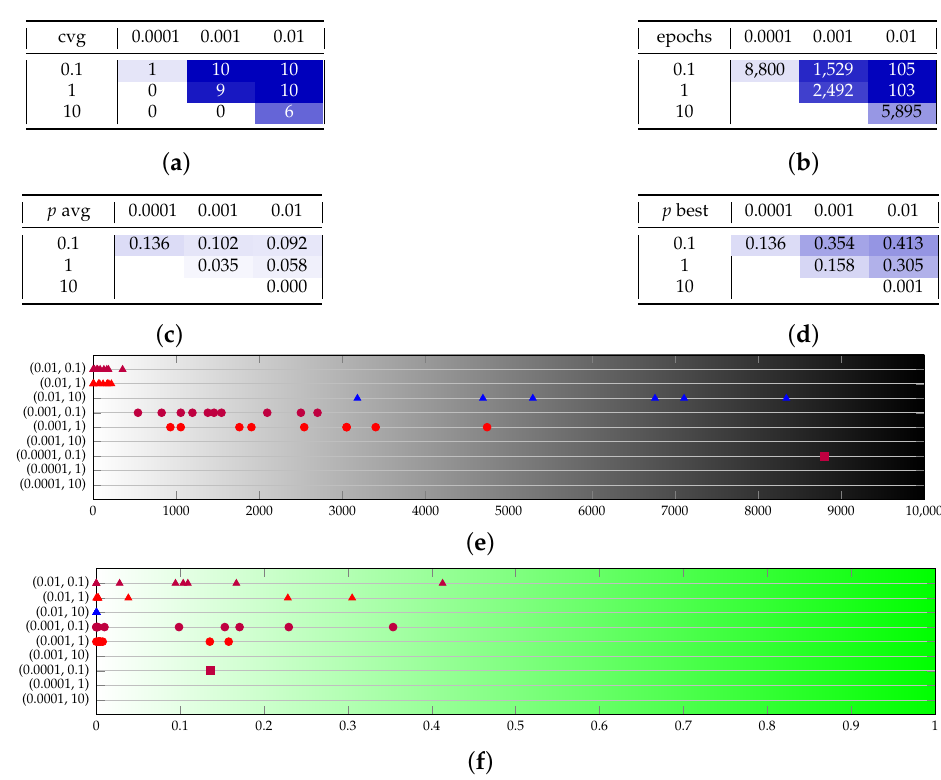
( e ) (e) Visual representation of the epochs before convergence. 1(0.0001,10)(0.0001,1)(0.0001,0.1)(0.001,10)(0.001,1)(0.001,0.1)(0.01,10)(0.01,1)(0.01,0.1) ( f ) (f) Visual representation of the p -value. Figure A7. Test set F provides a sensitivity analysis on the parameters for SPSA in the generator. Figure A7. The test set F provides a sensitivity analysis on the parameters for SPSA in the generator. In Subfigures A7a-A7d the Figure A7. The test set F provides a sensitivity analysis on the parameters for SPSA in the generator. In Subfigures A7a-A7d the rows represent the ratio between learning rate and perturbation factor, and the columns represent the generator learning rate. In ( a – d ) The rows represent the ratio between learning rate and perturbation factor, and the columns rows represent the ratio between learning rate and perturbation factor, and the columns represent the generator learning rate. In Subfigures A7e-A7f, the couples on the vertical axis are ( lr,ratio ) , marker shapes represent the learning rate and marker colors Subfigures A7e-A7f, the couples on the vertical axis are ( lr,ratio ) , marker shapes represent the learning rate and marker colors represent the generator learning rate. ( e , f ) The couples on the vertical axis are ( lr,ratio ) . Marker represent the ratio. represent the ratio. shapes represent the learning rate and marker colors represent the ratio. ( a ) Converging runs, out of Figure A7. The test set F provides a sensitivity analysis on the parameters for SPSA in the generator. In Subfigures A7a-A7d the 10. ( b ) Number of epochs before convergence, on average. ( c ) p -value for the χ 2 test once convergence Figure A7. The test set F provides a sensitivity analysis on the parameters for SPSA in the generator. In Subfigures A7a-A7d the rows represent the ratio between learning rate and perturbation factor, and the columns represent the generator learning rate. In is reached (average over converging runs). ( d ) p -value for the χ 2 test once convergence is reached rows represent the ratio between learning rate and perturbation factor, and the columns represent the generator learning rate. In Subfigures A7e-A7f, the couples on the vertical axis are ( lr,ratio ) , marker shapes represent the learning rate and marker colors Subfigures A7e-A7f, the couples on the vertical axis are ( lr,ratio ) , marker shapes represent the learning rate and marker colors (best run). ( e ) Visual representation of the epochs before convergence. ( f ) Visual representation of the represent the ratio. represent the ratio. p